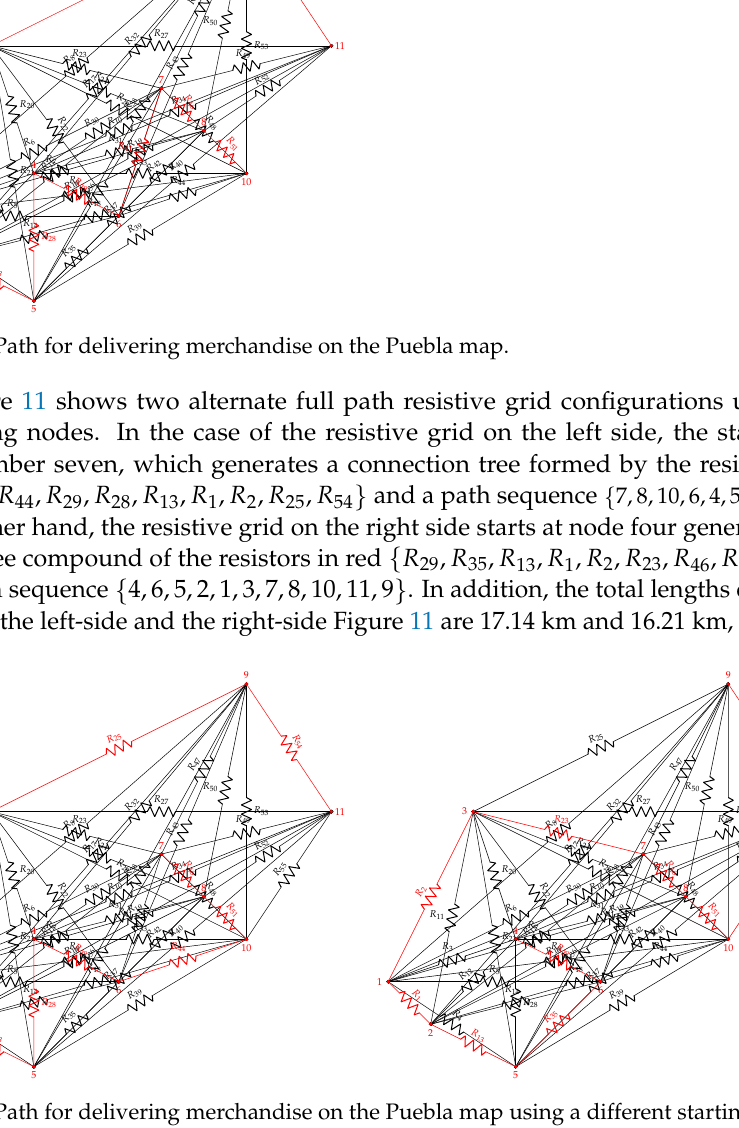
Figure 11. Path for delivering merchandise on the Puebla map using a different starting node. As it can be seen in Figure 12, the behavior of the CPU-time with respect to the number of merchandise delivery points has been successfully estimated. Start from the partial distribution zone (seven customers), the computation time, in order to transform the georeferential locations into a resistive grid, formulate the equilibrium equations, solve the system of equations, and find the path that runs through all the nodes that has been established according to increases in the number of customers by one until the maximum amount (fifty-four customers) has been